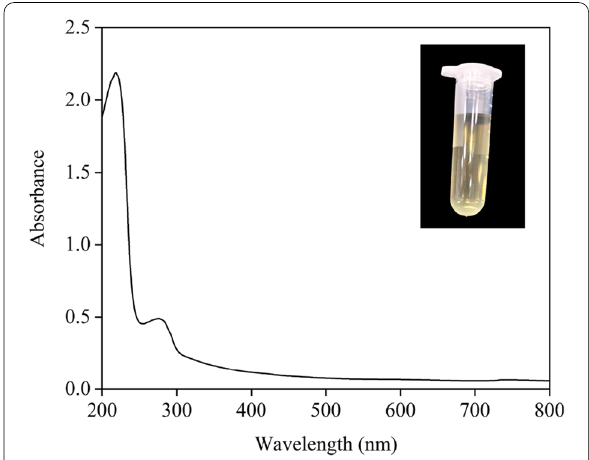
Fig. 3 The UV–vis absorption spectrum of purified CGLac, in10/20 mM citrate/phosphate buffer pH